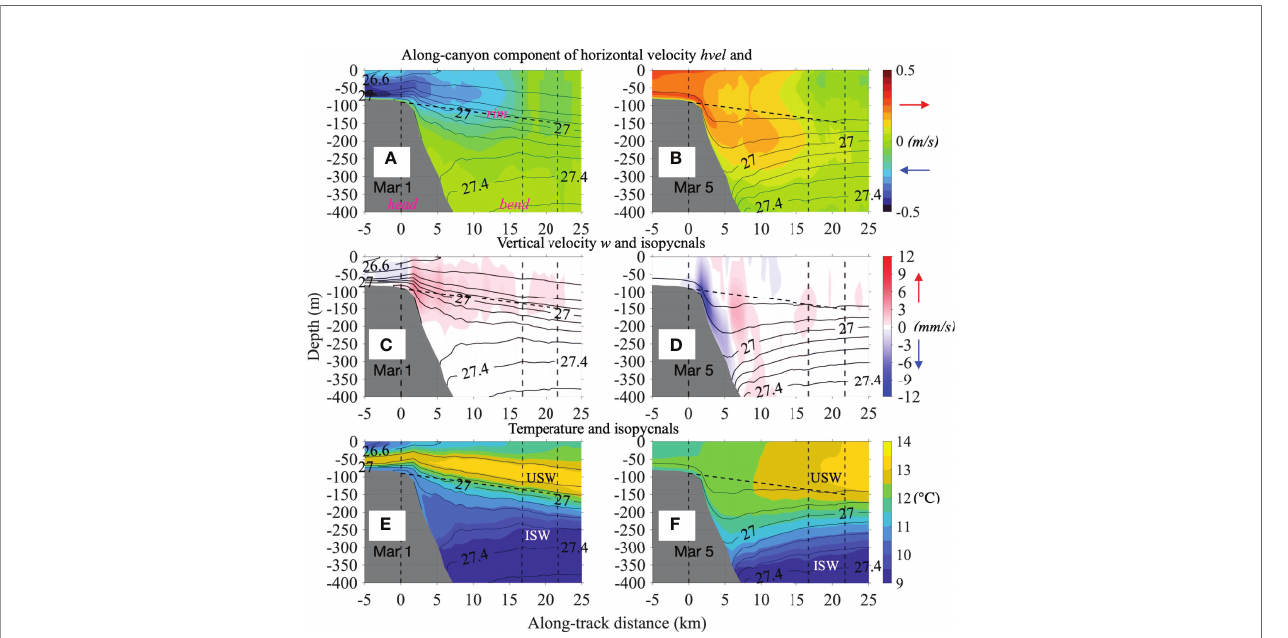
FIGURE 9 | Transect views of daily mean (A, B) along-canyon component of horizontal velocity, (C, D) vertical velocity w, and (E, F) temperature for the transect along the main axis of Wilmington Canyon (location of the transect is shown in Figure 2B ). On March 1, during canyon upwelling, fl ow was characterized by up- canyon horizontal velocity and upward vertical velocity. The lower layers of USW and upper layers of ISW from inside the canyon upwelled onto the outer continental shelf. The deepest source of the upwelled water was from about 215 m depth near the canyon mouth, which was about 50 m below the canyon rim at the canyon ’ s mouth. On March 5, during canyon downwelling, there were bottom-intensi fi ed currents fl owing down-slope inside the canyon near the canyon head with horizontal velocity of 0.3 m/s and downward vertical velocity of 15 mm/s. The previously upwelled dense slope now fell to 200-350 m depths within the